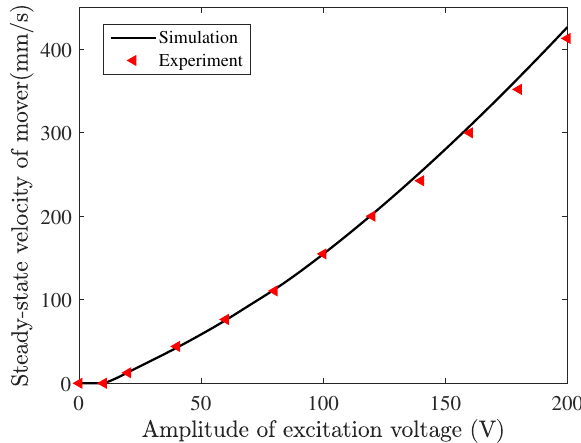
Figure 28. Velocity of the mover versus the amplitude of the excitation voltage.